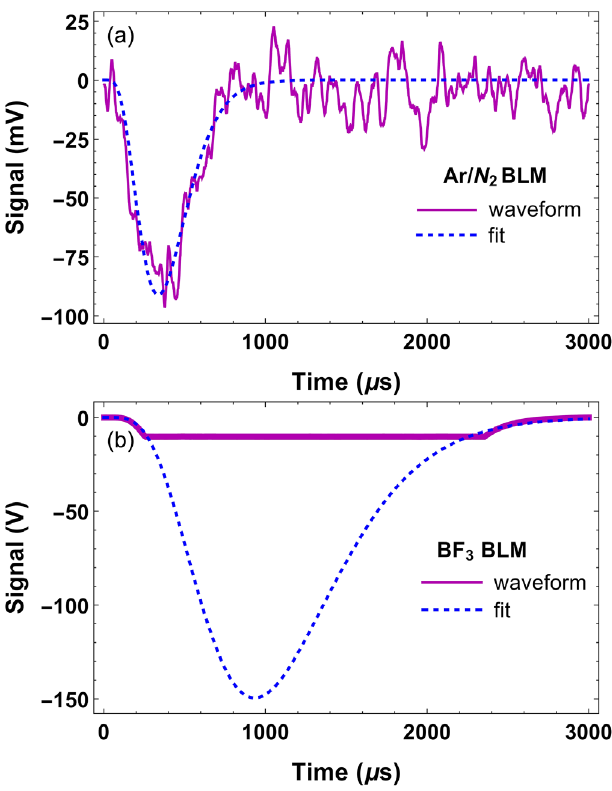
FIG. 29. The waveforms of the beam loss signal and the waveform fit in a controlled beam loss event for the (a) Ar = N 2 BLM and (b) BF 3